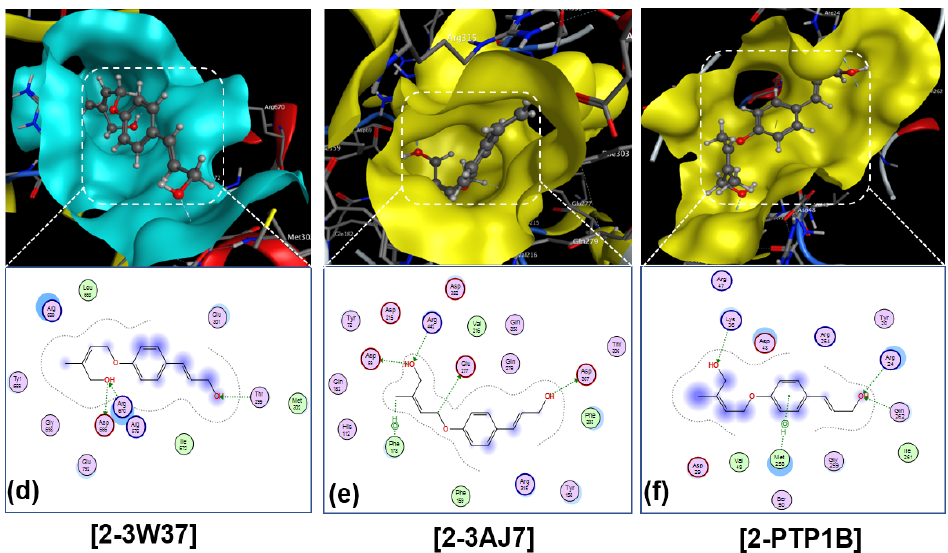
Figure 8. Figure 8. Visual presentation and in-pose interaction map of ligand-3W37, ligand-3AJ7, and ligand-PTP1B inhibitory isolated compounds 1 and 2 : ( a ) 1-3W37 , ( b ) 1-3AJ7 , ( c ) 1-PTP1B , ( d ) 2-3W37 , ( e ) 2-3AJ7 , ( f ) 2-PTP1B . In molecular ren- dering , black, gray (white), blue, and red are standard colours for carbon, hydrogen, nitrogen, and oxygen atoms, re- spectively.